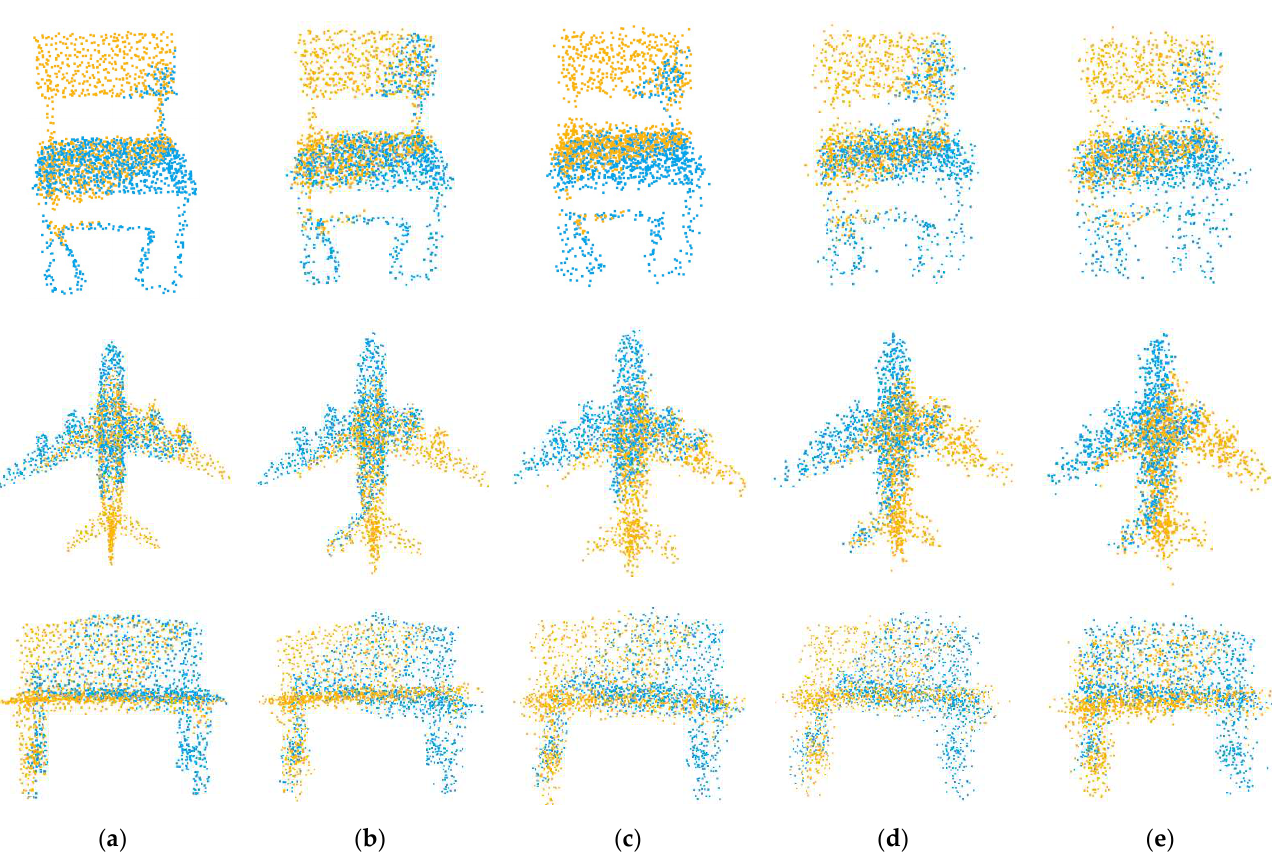
Figure 8. Example results on partially overlapping point clouds with varying Gaussian noise. ( a ) noise = 0.01; ( b ) noise = 0.02; ( c ) noise = 0.03; ( d ) noise = 0.04; ( e ) noise = 0.05.